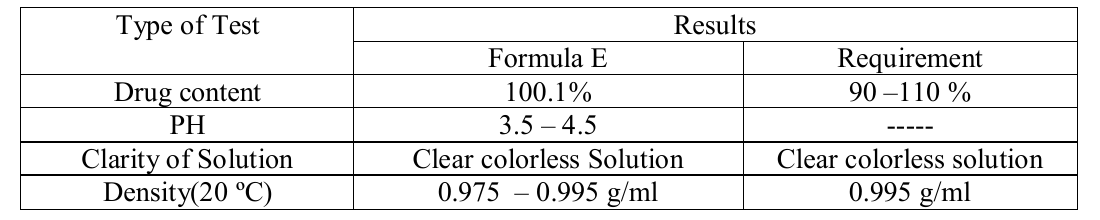
Table-6 Results of the Quality Control Test for the selected Formula (formula E) of Econazole Nitrate This indicates that the method of preparation is efficient and